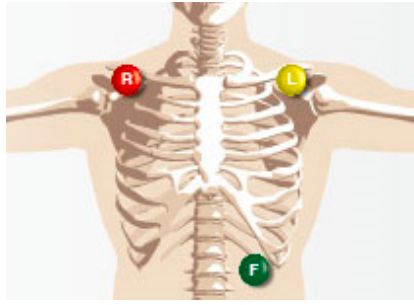
Figure 2. Location of the electrode paste.